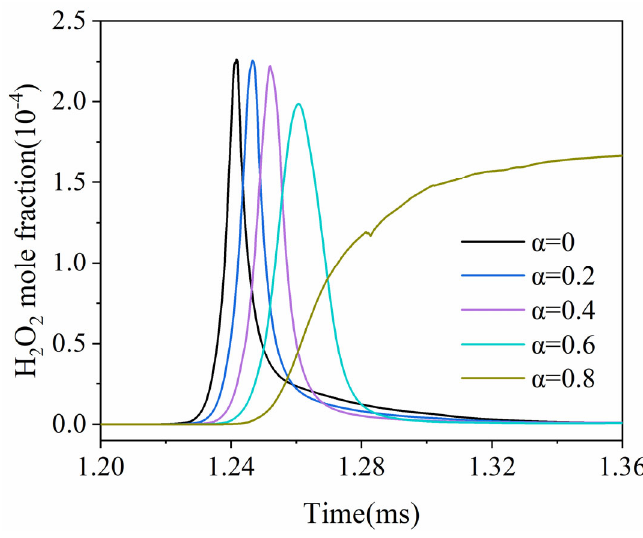
Figure 6. Variation curves of the mole fraction H 2 O 2 under different α .